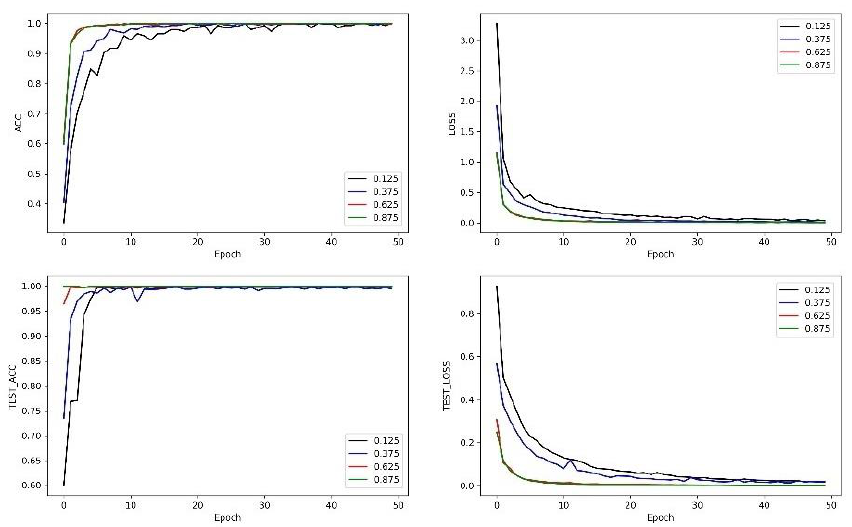
Figure 9. Results of TM2 in di ff erent working conditions.